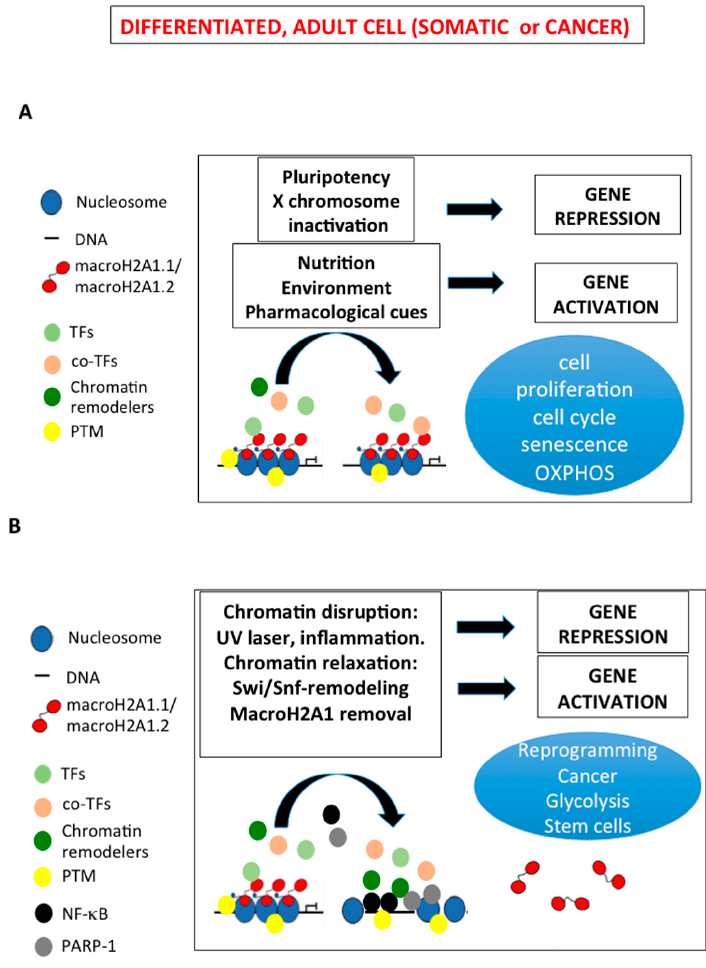
Figure 3. MacroH2A1-dependent integration of nutritional, environmental and pharmacological inputs into gene expression programs and cellular outputs (differentiation, proliferation, cycle, senescence and oxidative phosphorylation metabolism). ( A ) Activity and abundance of macroH2A1 isoforms on specific sites can be modulated by post-translational modification (PTM) and by interactions with neighboring histone PTM, transcription factors, co-TF and chromatin remodelers. ( B ) Disruption of macroH2A1 binding to chromatin by genetic manipulation, ultraviolet (UV) laser-induced localized damage or inflammatory stimuli leads to macroH2A1 removal, resulting in chromatin relaxation, enhanced accessibility to nuclear factor κ -light-chain-enhancer of activated B cells (NF-Kb) and PARP-1-dependent transcriptional activation, and for re-expression of reprogramming genes (see text for details).